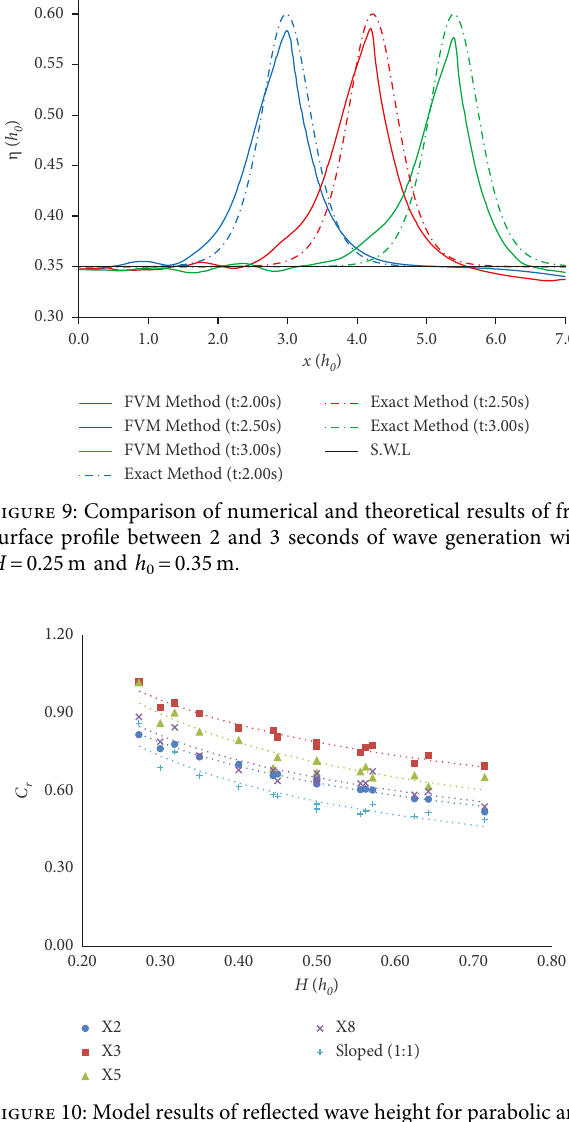
Figure 12: The incident wave and relevant reflected waves from sloped and parabolic walls ( H / h 0 :